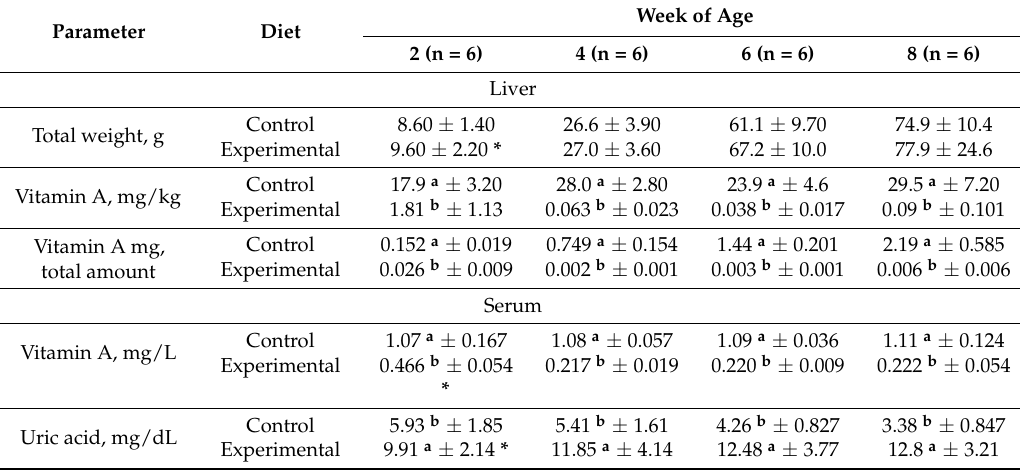
Table 5. Liver weight, concentration of vitamin A in liver on fresh basis as well as serum concentrations of vitamin A and uric acid in growing turkeys (mean ±